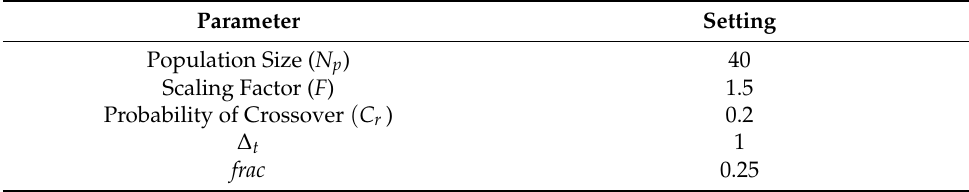
Table 4. Parameter settings for the DDE